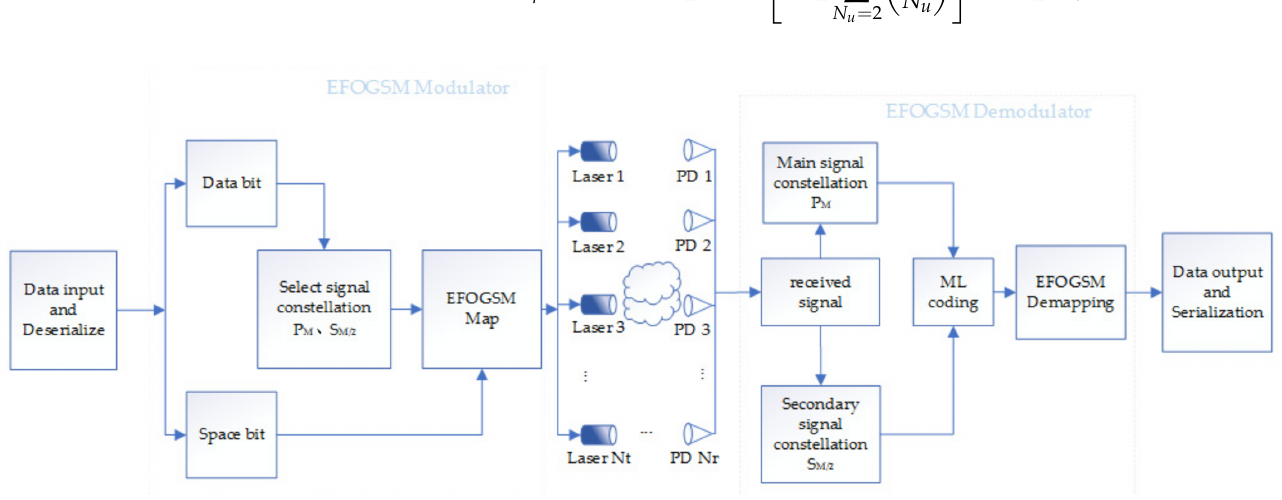
Figure 1. EFOGSM system structure block diagram.